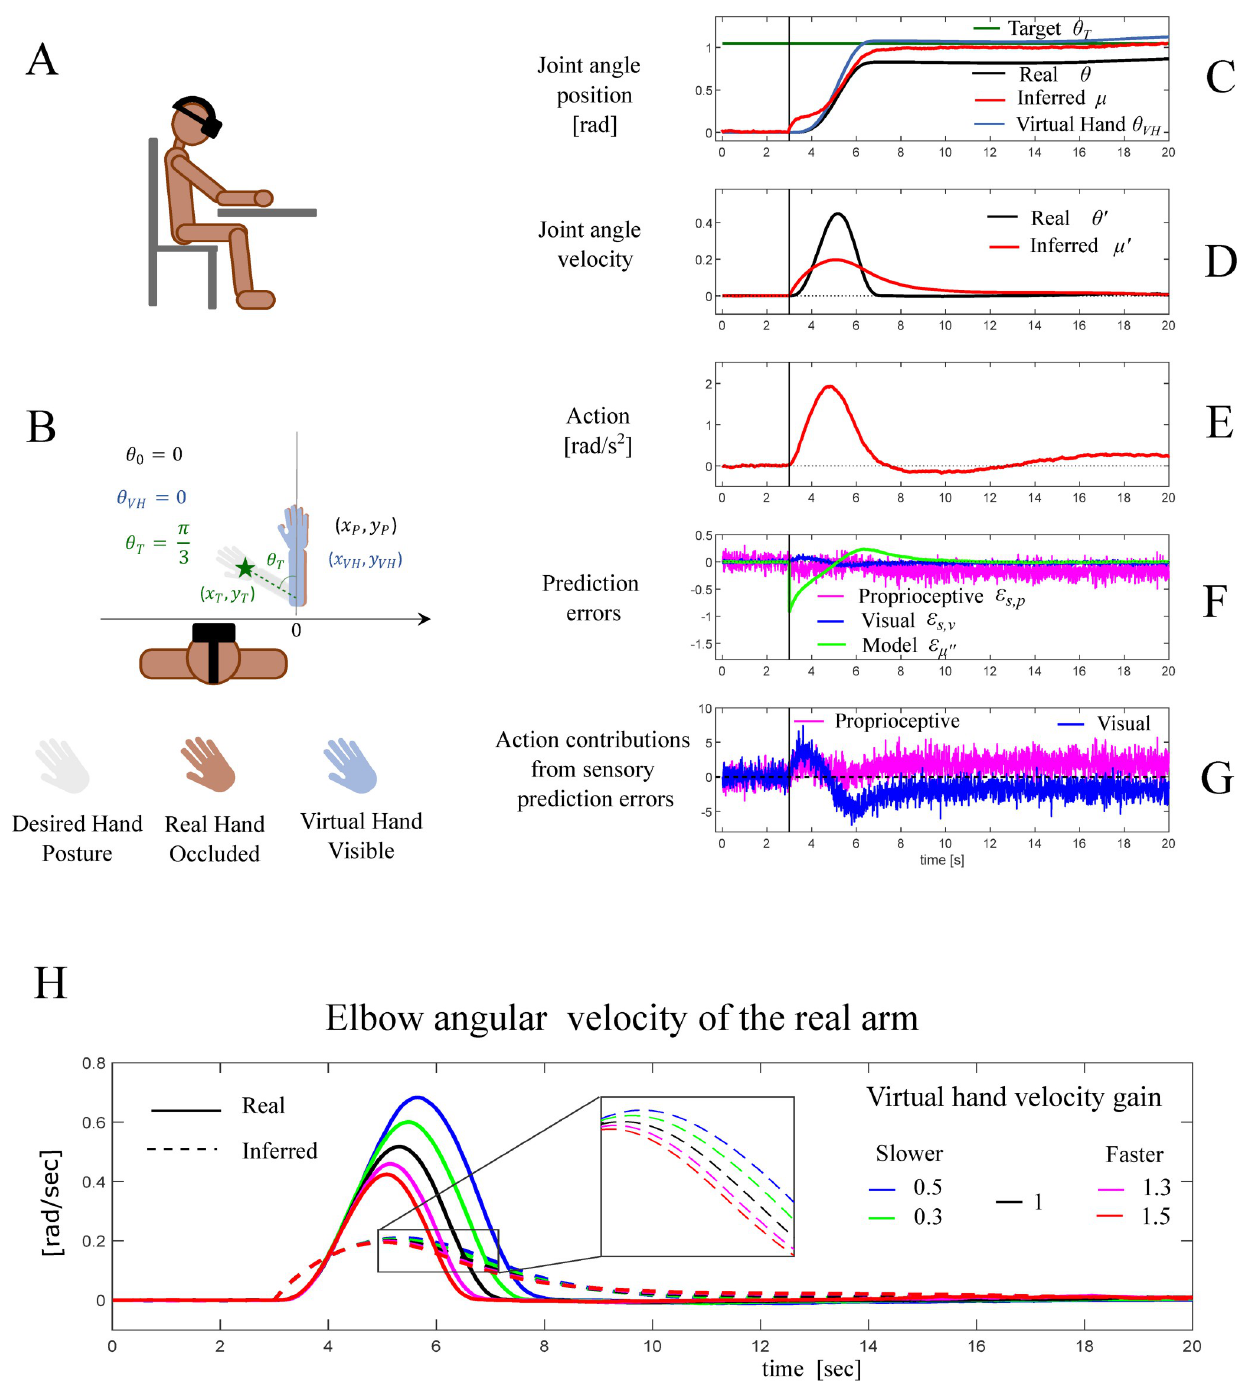
Fig 9. Third simulation: reaching under visuo-proprioceptive conflict that cannot be resolved by acting. (A) Schematic representation of the agent seeing a virtual hand through a virtual reality stereoscopic headset. (B) Task specification. The agent has to reach a target placed at [ x T , y T ] = g(θ T ), while undergoing an illusory ownership over a virtual hand, which moves along the real hand but with a velocity gain of 1.3. (C-G) Dynamics of the model variables during the task. The vertical bars mark the time at which the target location is disclosed. (C) Joint angle of the real (solid black) and inferred (solid for which the hand is on the target. (D) Real red) arm configurations, expressed in radians. The green line represents the desired arm configuration θ T (black) and inferred (red) velocity of the elbow joint angle. (E) Action, represented in our model as an angular acceleration. (F) The three prediction errors considered in the model: model dynamics error (green) and the two sensory errors, proprioceptive (magenta) and visual (blue). Please note that in this plot, the prediction error units correspond to different dimensions. (G) Contributions of proprioceptive (magenta) and visual (blue) errors in determining